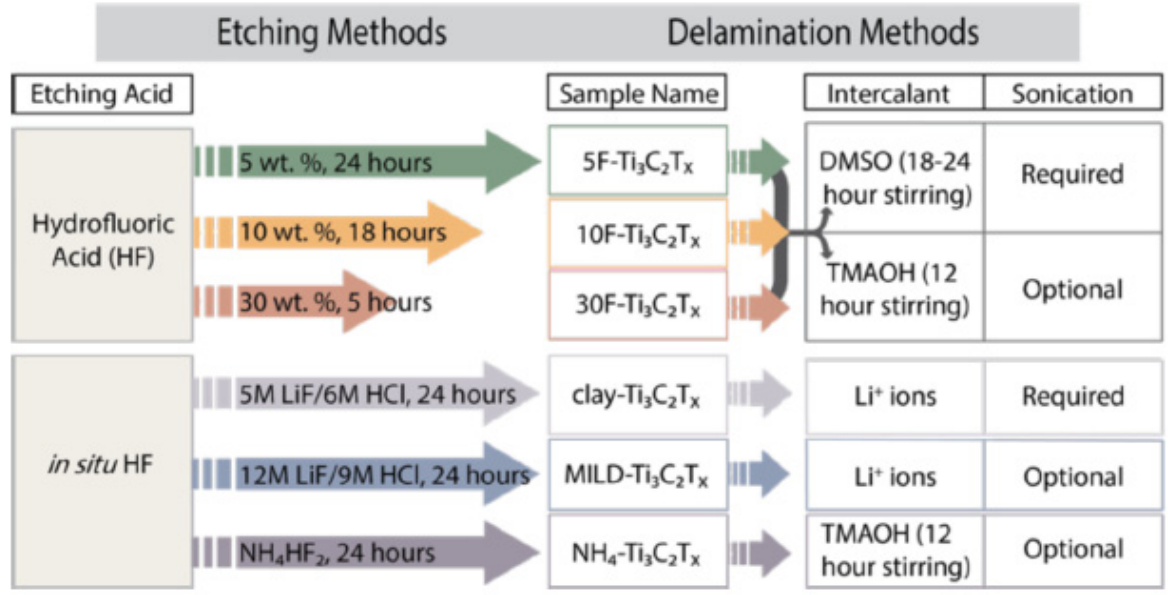
Figure 3. Schematic diagram of employment three distinct concentrations of HF for three separate times, and this will be adequate to synthesise Ti 3 C 2 . Reproduced with permission from [42]. Copyright 2015 Wiley.